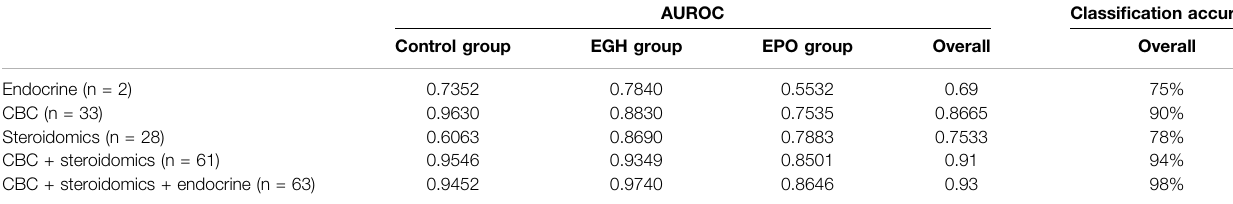
TABLE 2 | The AUROC of classi fi cation of the various datasets after 100 Monte Carlo Cross Validations.